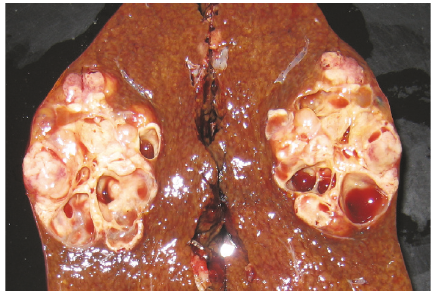
Figure 4: Resected specimen. The mass measured 35 × 50 mm and was located on the hepatic